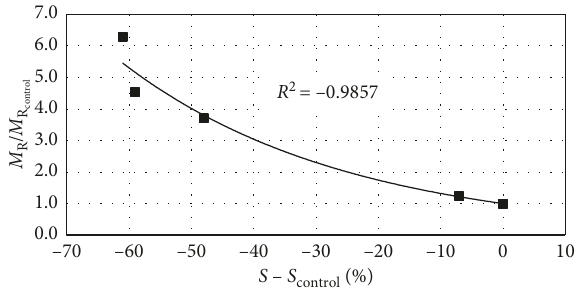
Figure 7: LTRC temporal M